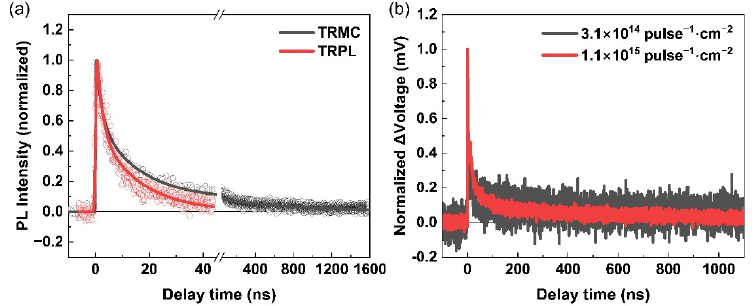
Figure 3. ( a ) Comparison between TRMC and TRPL kinetics of MAPb(Br 0.18 I 0.82 ) 3 SCs at room temperature. The TRPL (TRMC) solid lines are fitting curves based on multiple-exponential decay functions, and the detailed fitting parameters are shown in Table 2. ( b ) TRMC kinetics of MAPb(Br 0 . 18 I 0 . 82 ) 3 SCs at different excitation fluencies.